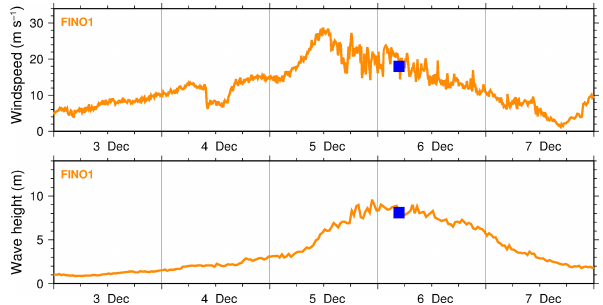
Figure 4. Time series during 5 days, which include storm Xaver of the observations in station FINO-1 (orange line) together with the Saral/Altika observation (blue full square). Top panel: wind speed (ms − 1 ); and bottom panel: significant wave height (m). SARAL/AltiKa passed over the German Bight during storm Xaver when the surge was at its maximum (the data during the overflight are plotted with a full blue